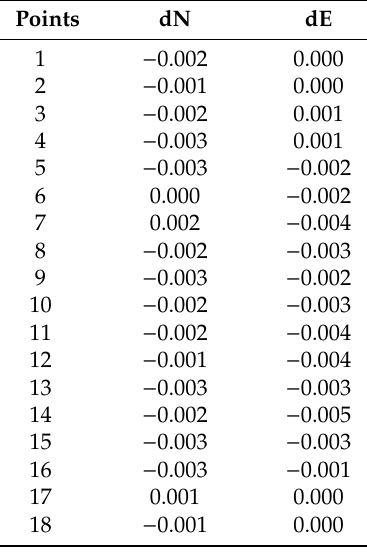
Table 5. Sundial metal band survey: coordinates di ff erences (total station vs. TLS), values in